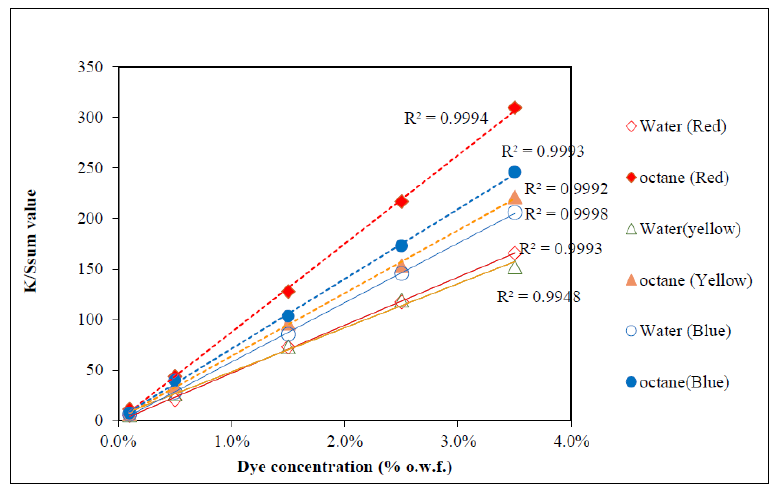
Figure 8. Calibration curves for computer colour matching.